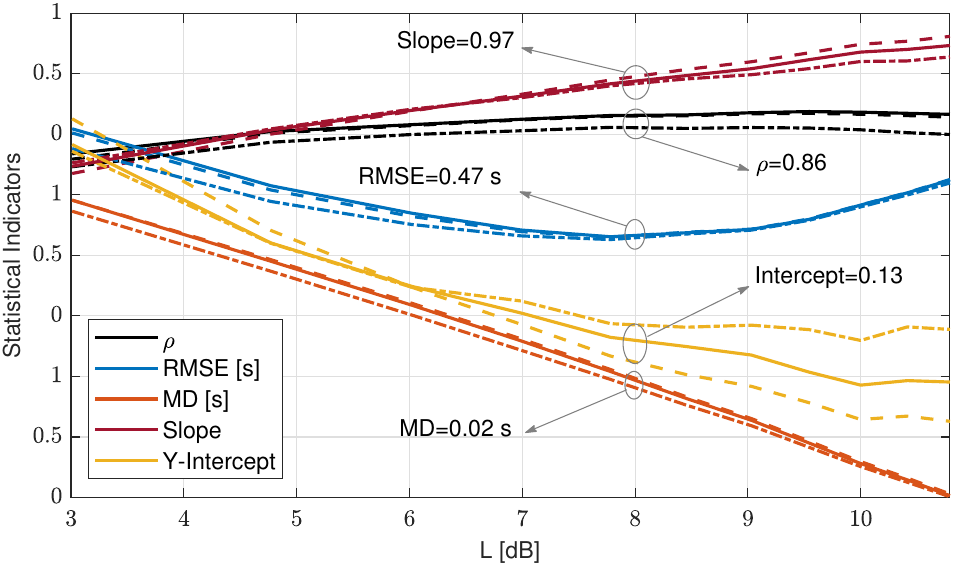
Figure 9. Statistical indicators comparing the L-dB method T L − dB and zero-crossing method T z as a function of threshold value L (dB) parameterized by averaging time (IJmuiden campaign, 29 March– 17 June 1920 records). The dashed dots indicate weekly averaged indicators. The dashed line indicates monthly average. The solid trace indicates the indicators computed for the whole 80 day